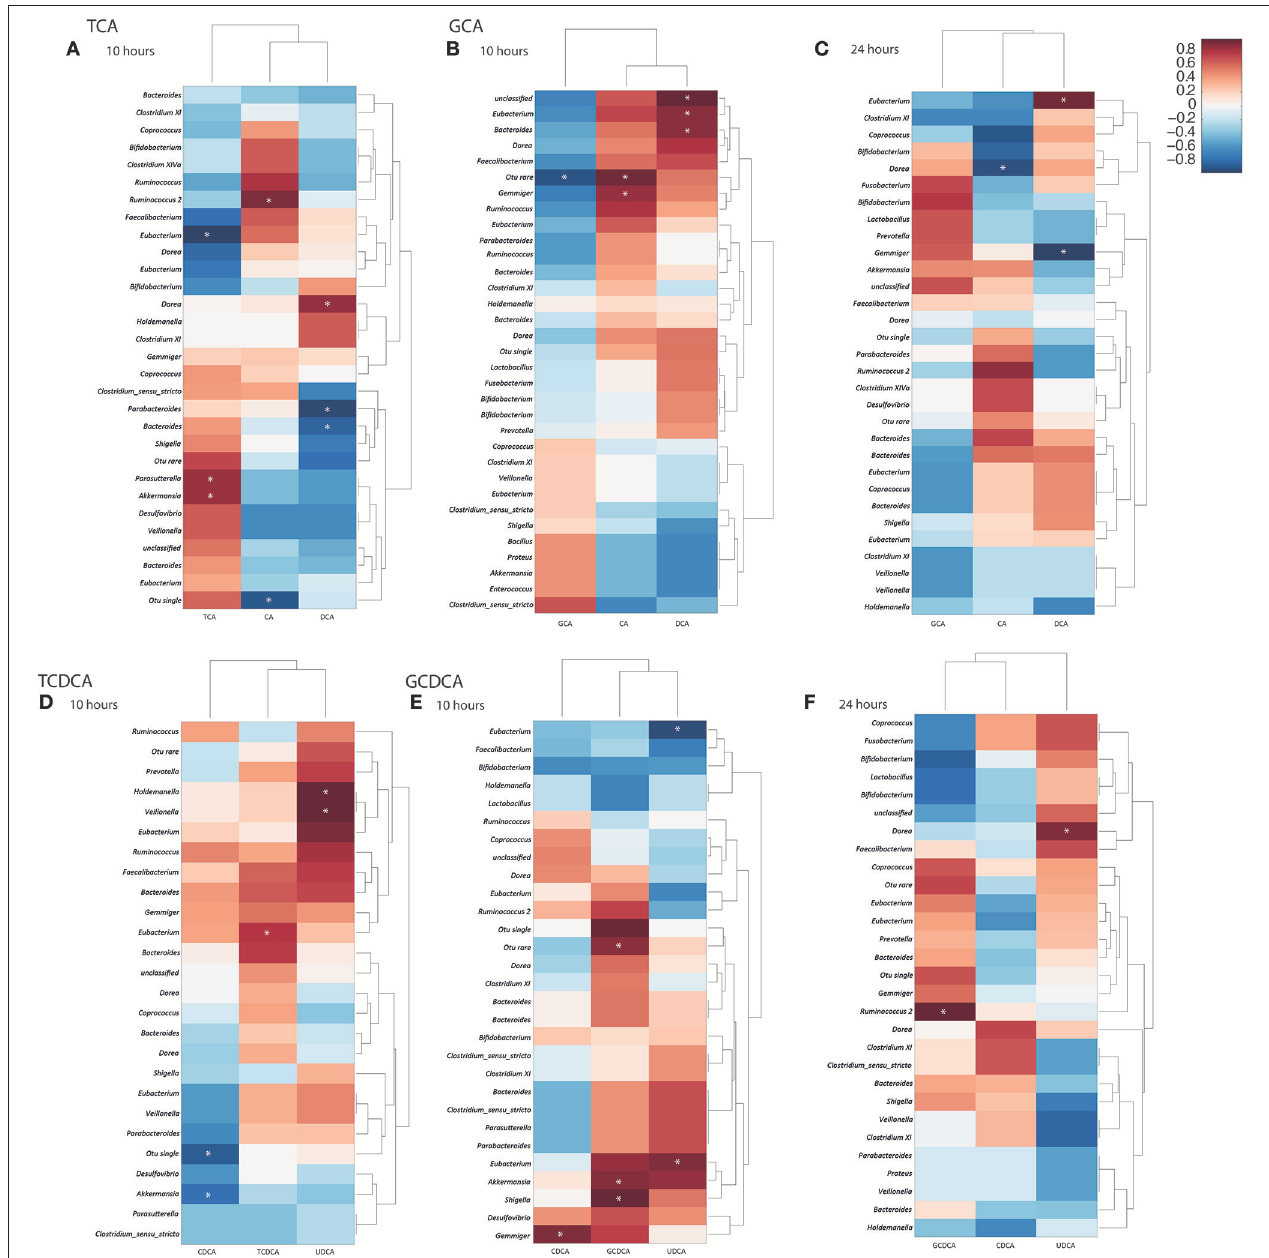
FIGURE 3 | Correlation matrices constructed from bile acid moieties and fecal bacterial genera at 10 and 24 h following bile acid supplementation. (A) 10 h post taurocholic acid (TCA); (B) 10 h and (C) 24 h post glycocholic acid (GCA); (D) 10 h post taurochenodeoxycholic acid (TCDCA); (E) 10 h and (F) 24 h post glycochenodeoxycholic acid (GCDCA) supplementation. Correlation coefficients presented as heat maps with dendrograms indicating relatedness between variables. *Significant correlations ( p < 0.05). CA, cholic acid; CDCA, chenodeoxycholic acid; DCA, deoxycholic acid; UDCA, ursodeoxycholic